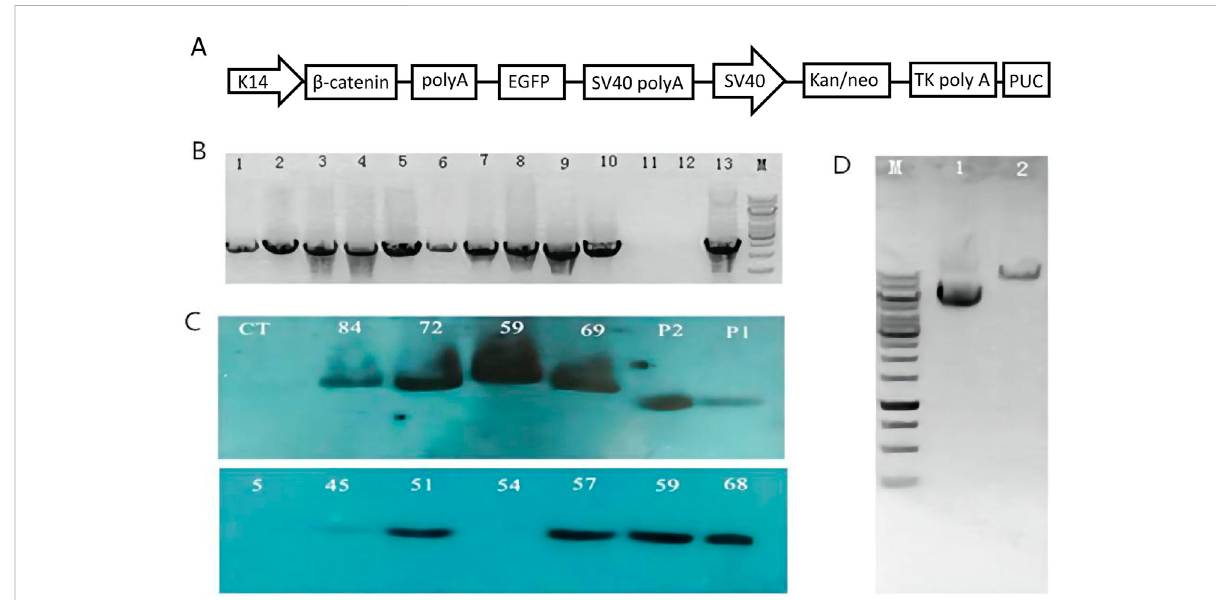
FIGURE 1 Generation of ovine β -catenin transgenic mice (F0). (A) Schematic diagram of transgenic vector (pK14- β -catenin-EGFP). (B) Agarose gel analysis on PCR products from genomic DNA extracted by transgenic founder mice tail. The PCR products from mouse number 5, 45, 51, 54, 57, 59, 68, 69, 72, and 84 are shown in well #1 to #10 respectively; the PCR product with H 2 O as a control temple is shown in well #11; the negative PCR productwithDNAextractedfromwildtypemousetailisinwell#12;PCRproductusingtransgenicvectorDNAastemplateisshowninwell#13. (C) Southern blot with DNA from transgenic mice skin. WT, a sex- and age-matched wild-type control; p1, p2 plasmid controls. (D) Analysis of β - catenin Vector DNAbyAseI digestion on 1%agarose gel. Lane 1:VectorDNAwithout any restriction enzymedigestion; Lane 2:Vector DNA digested by AseI; M: 1 Kb DNA ladder.